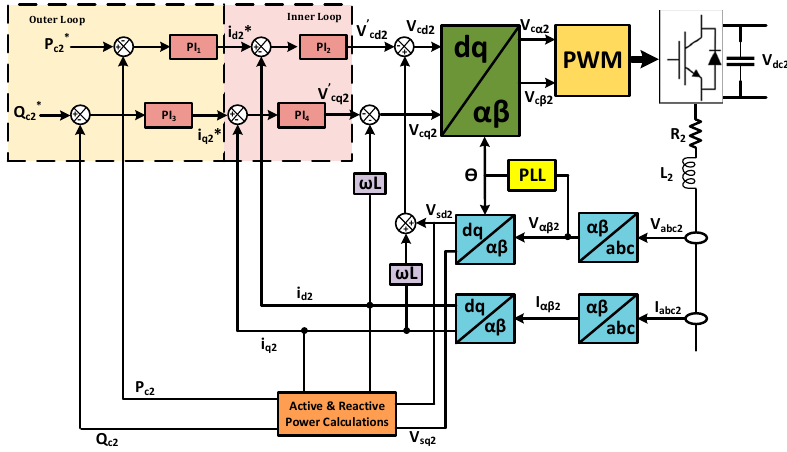
Figure 3. Control scheme at the inverter station.